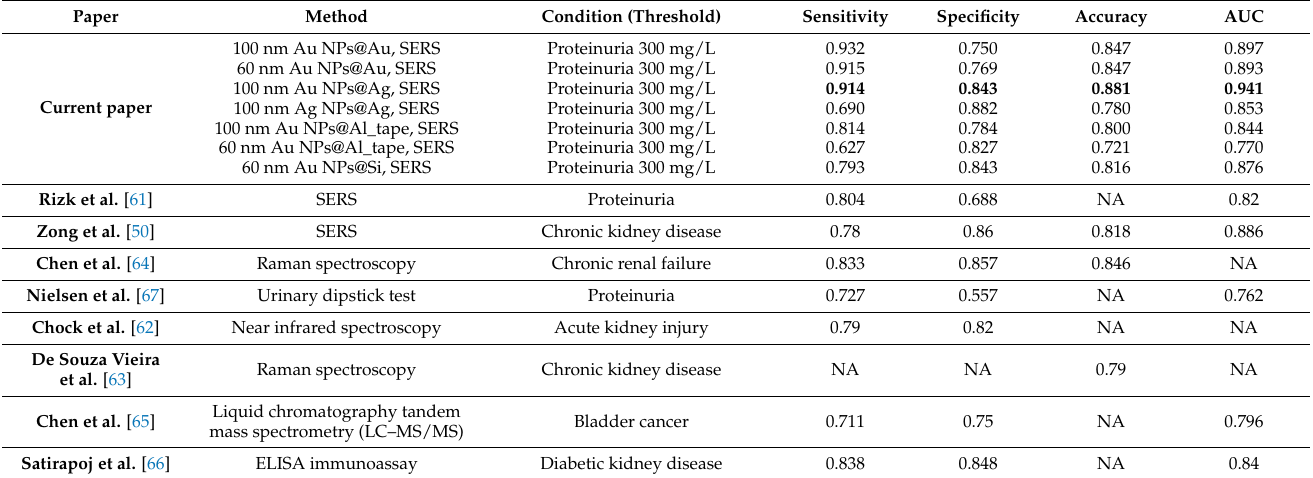
Table 3. Summary table of experimental papers on protein detection in human